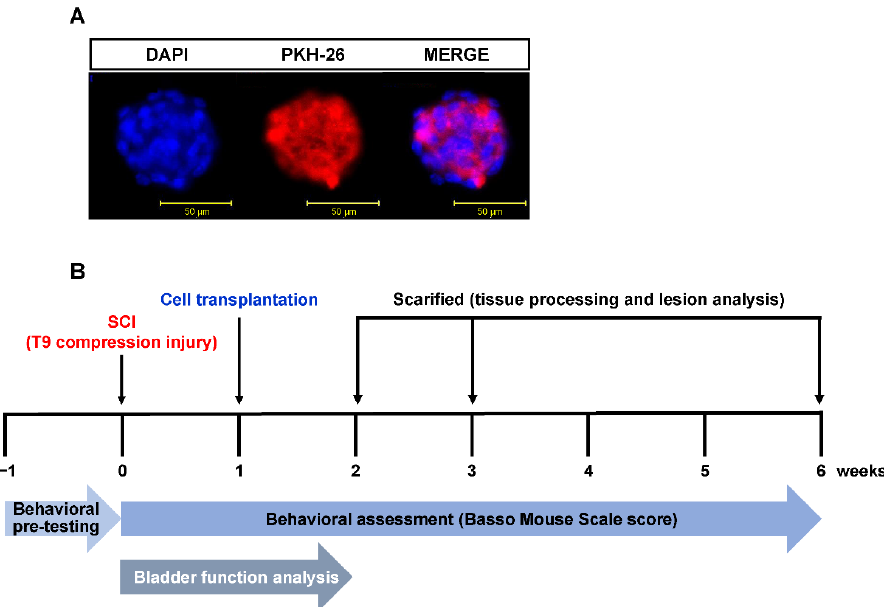
Figure 9. Experimental time schedule for in vivo SCI model of cell transplantation, behavioral assessment, bladder functional analysis, and tissue harvest. ( A ) mNPC labeling with the fluorescent dye PKH-26 (red); cellular nuclei were stained with DAPI (blue). ( B ) All mNPC, pLXSN-mNPC, and hADC-mNPC transplantations were performed 1 week after SCI. Transplanted cell retention was assessed in spinal cord explants at 1, 2, and 5 weeks after cell transplantation. Assessments of forearm function were performed before and after injury, and weekly following transplantation. Bladder function analysis was performed simultaneously twice a day until 2 weeks after